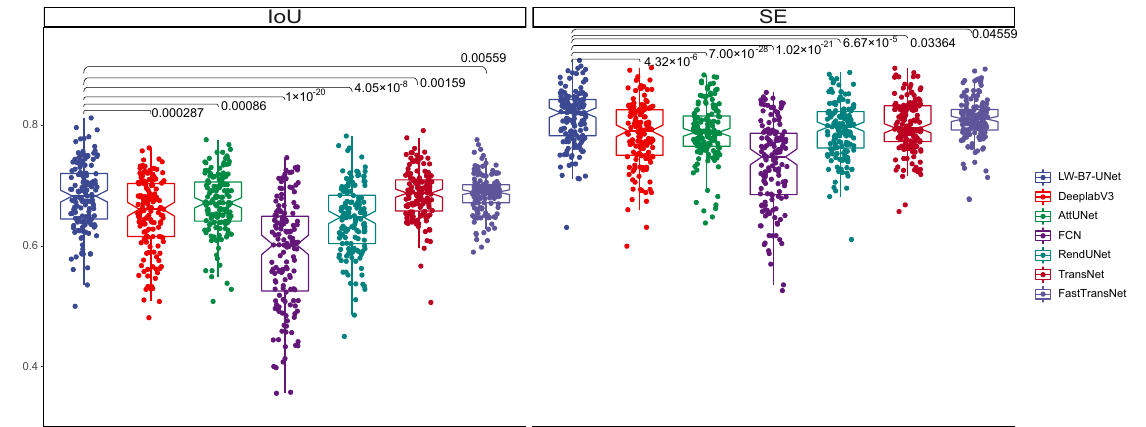
Figure 5. Box plots of the SE and IoU values obtained from the tests on the test set and its Kruskal– Wallis results. The results show that our model achieves the highest SE and IoU values in the test of nasopharyngeal carcinoma segmentation and is significantly different from other